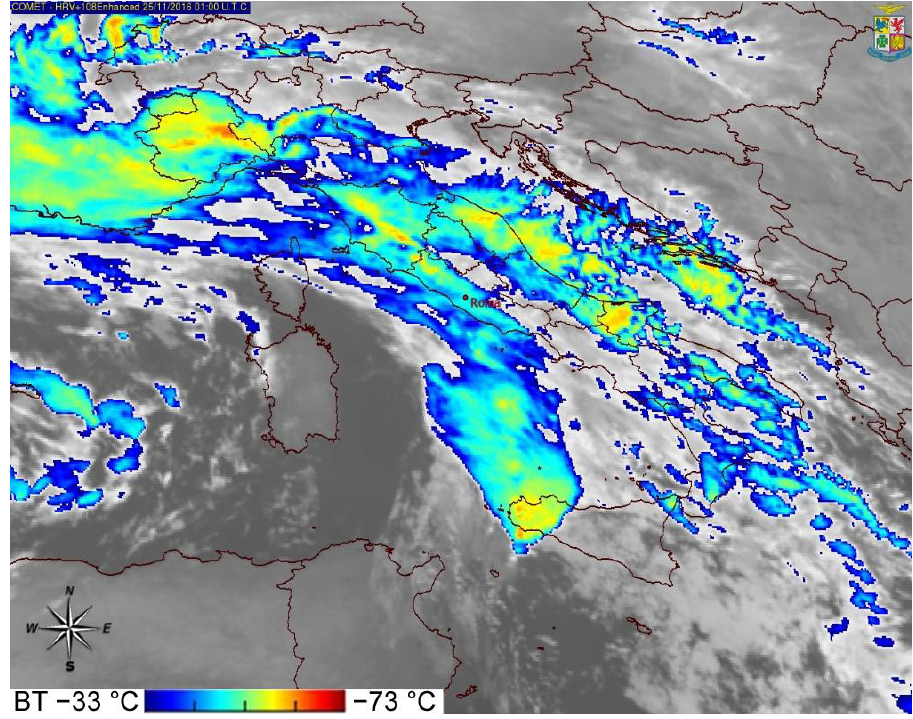
Figure 4. MSG enhanced nephoanalysis of 25.11.2016 at 01:00 UTC.